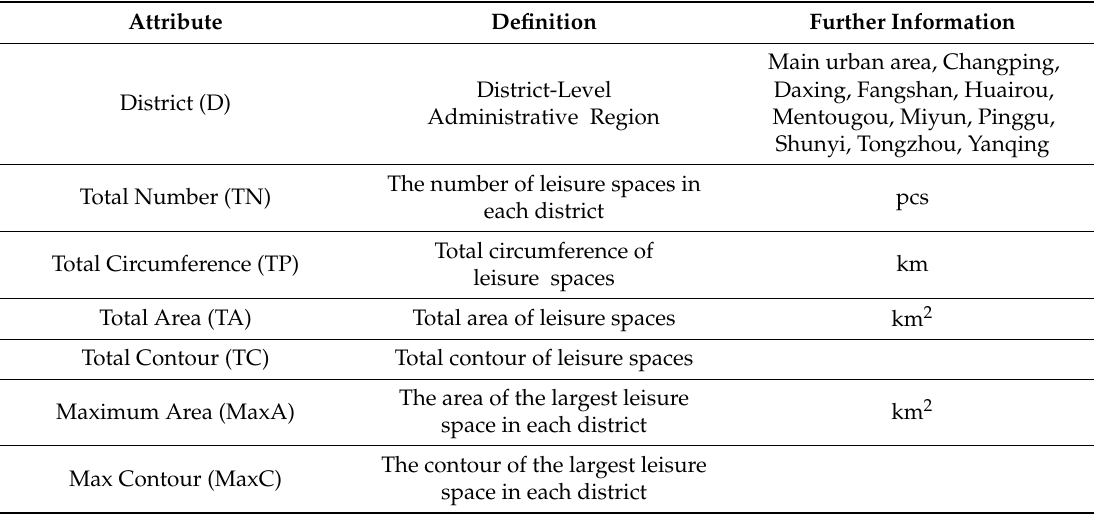
Table 3. Definitions of the geometric and statistical